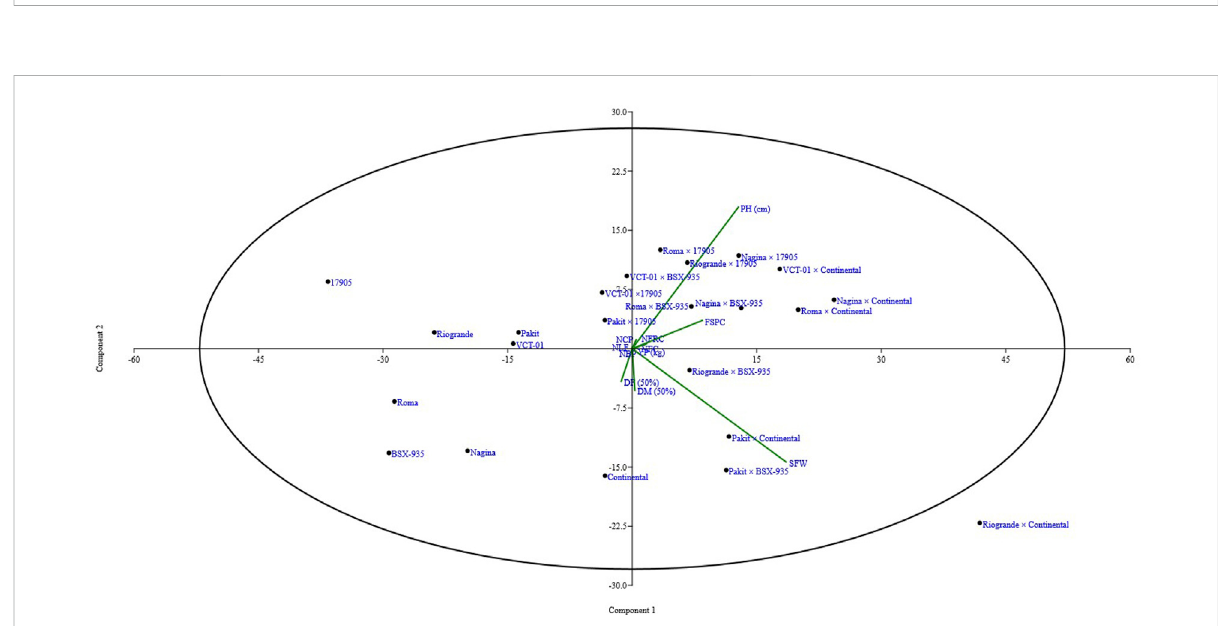
FIGURE 3 Scatter biplot of different yield and yield-related traits of parents and hybrids. It shows that several variables are correlated with each other and several are not